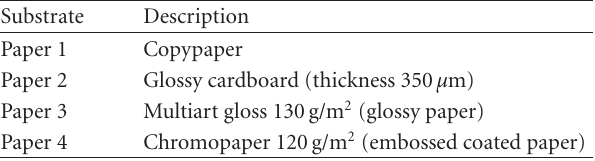
Table 2: Papers which were selected as antenna substrates and their characteristics.